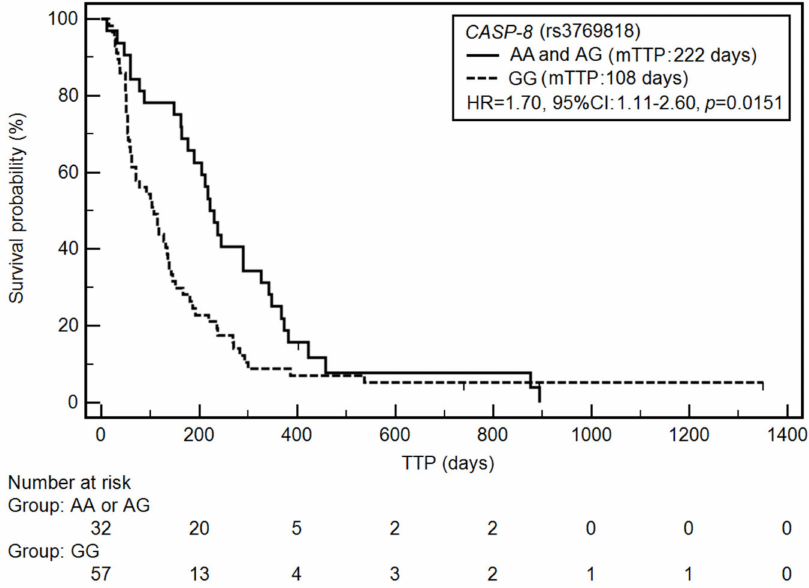
Figure 2. Kaplan–Meier curves illustrating time-to-progression (TTP) differences between genotypes AA and AG, GG of the CASP-8 gene